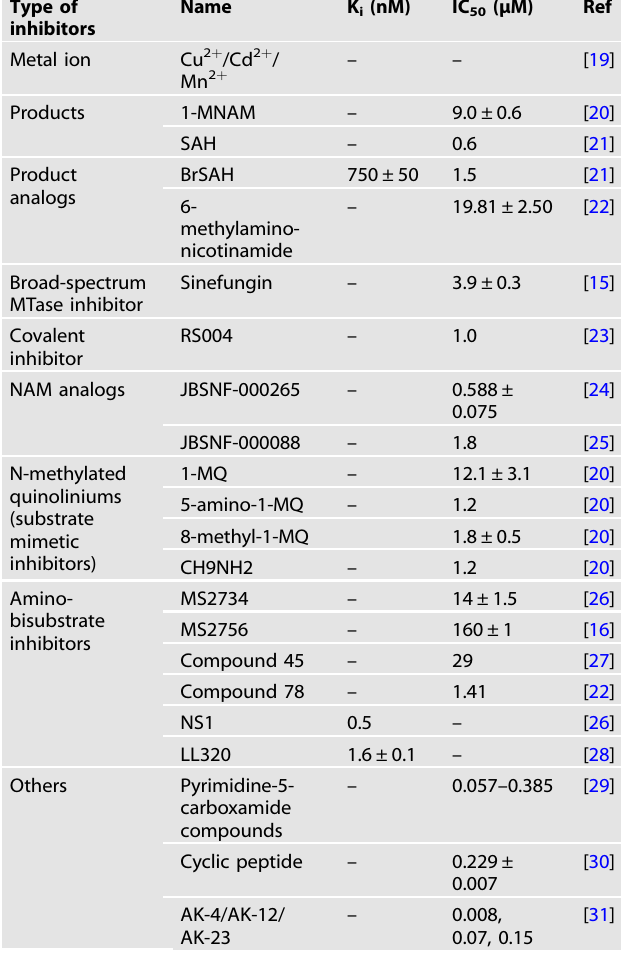
Table 1. Inhibitors of NNMT.